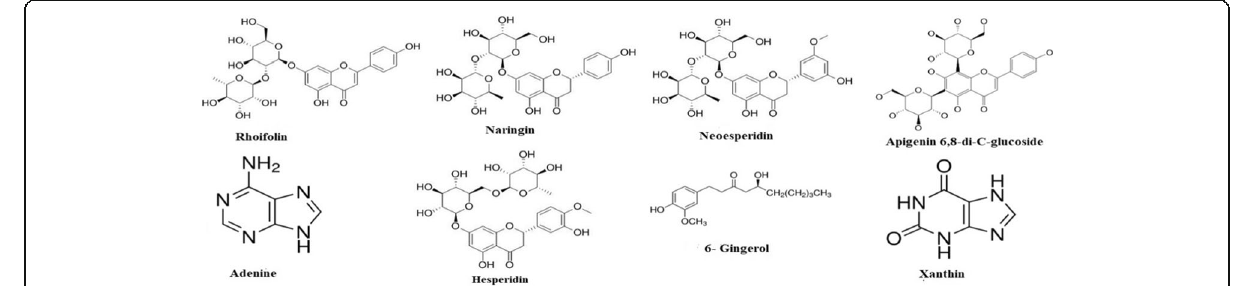
Fig. 1 2D structures of COVID-19 spike protein ligands